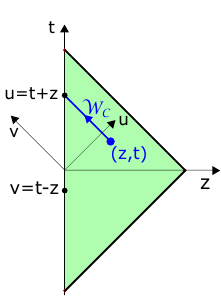
Figure 13 . Wilson line dressing to de(cid:12)ne a small-gauge-invariant bulk operator O u ( u; v ). The right-moving operator O v ( u; v ) would be constructed using a Wilson line along the u -direction, and leads to a factor e iq (cid:3)( v )